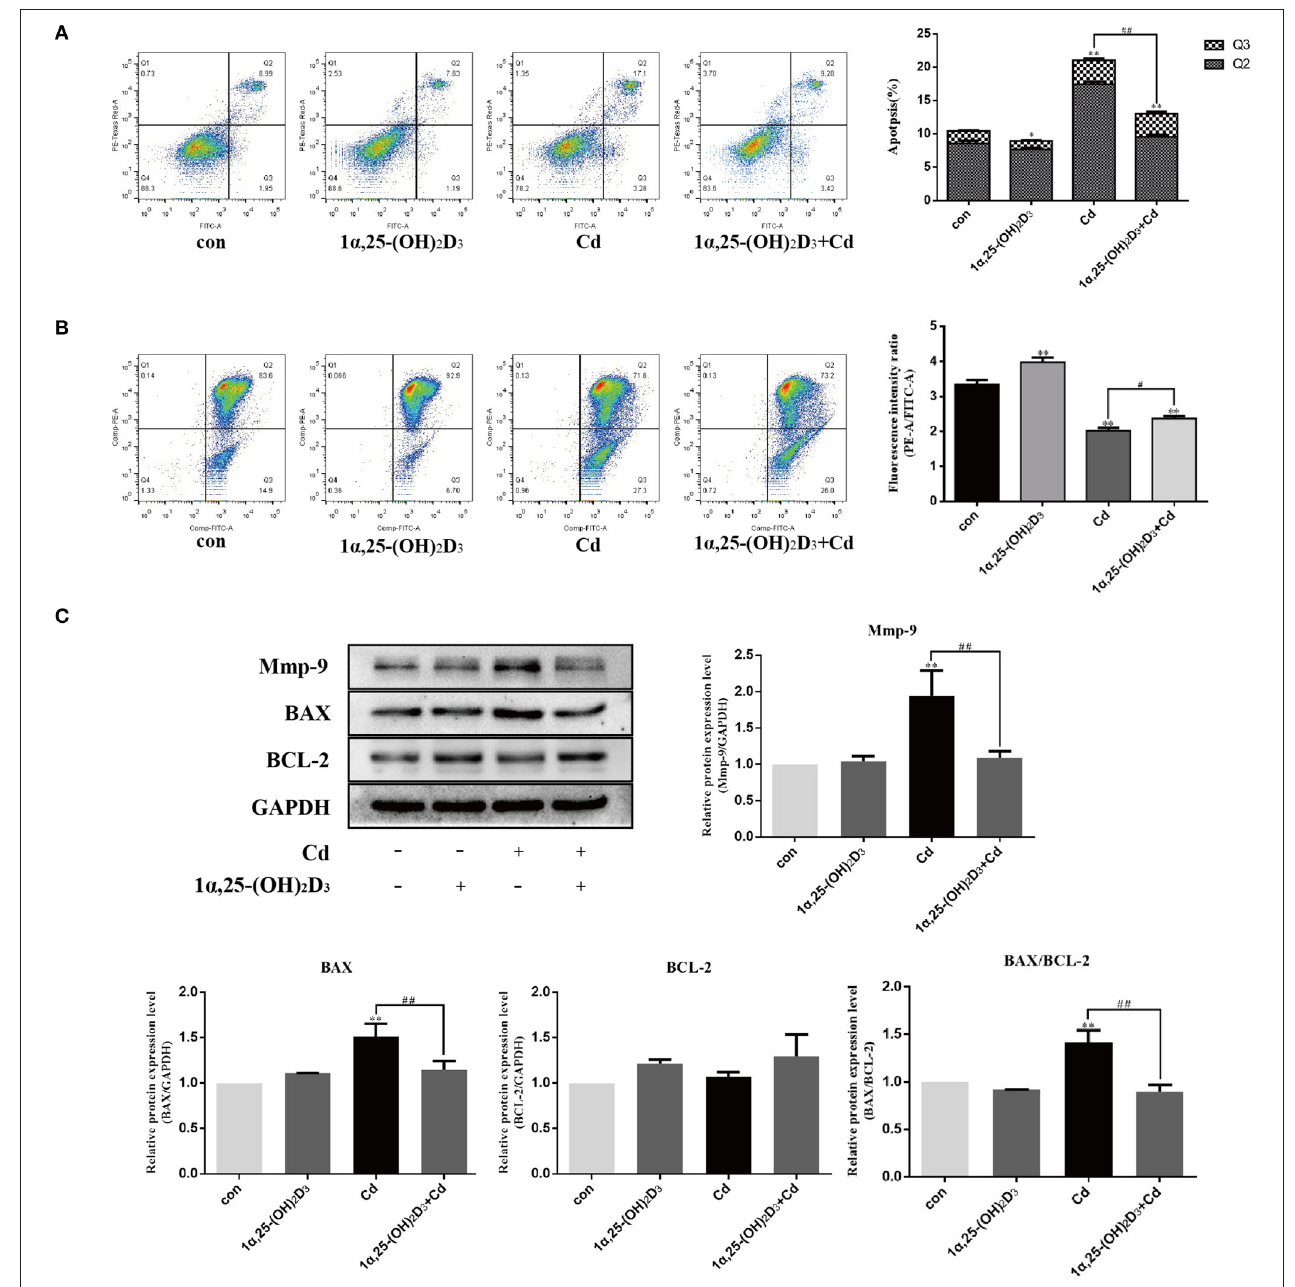
FIGURE 5 | 1 α ,25-(OH) 2 D 3 inhibited the effect of Cd on apoptosis and MMP-9 expression in chondrocytes. (A) Apoptosis of chondrocytes after pretreatment with 10 − 8 M 1 α ,25-(OH) 2 D 3 for 1 day followed by 1 day of combined treatment with 2 µ M Cd. Compared with Cd treatment alone, the 1 α ,25-(OH) 2 D 3 and Cd combination treatment reduced apoptosis in chondrocytes. (B) Mitochondrial membrane potential of chondrocytes pretreated with 10 − 8 M 1 α ,25-(OH) 2 D 3 for 1 day followed by 1 day of combined treatment with 2 µ M Cd. Compared with the Cd treatment alone, the 1 α ,25-(OH) 2 D 3 and Cd combination treatment increased the mitochondrial membrane potential of the chondrocytes. (C) Expression of MMP-9, Bax, and Bcl-2 protein in chondrocytes pretreated with 10 − 8 M 1 α ,25-(OH) 2 D 3 for 1 day followed by 3 days combined treatment with 2 µ M Cd as detected by Western blot showed that, compared with the Cd treatment alone, the 1 α ,25-(OH) 2 D 3 and Cd combination reduced Bax and MMP-9 expression, reduced the Bax/Bcl-2 ratio. All data are represented as mean ± standard deviation; n = 3; * P < 0.05 and ** P < 0.01, significant difference relative to the day 0 group; # P < 0.05 and ## P < 0.01, significant difference between the combined treatment group and Cd monotherapy